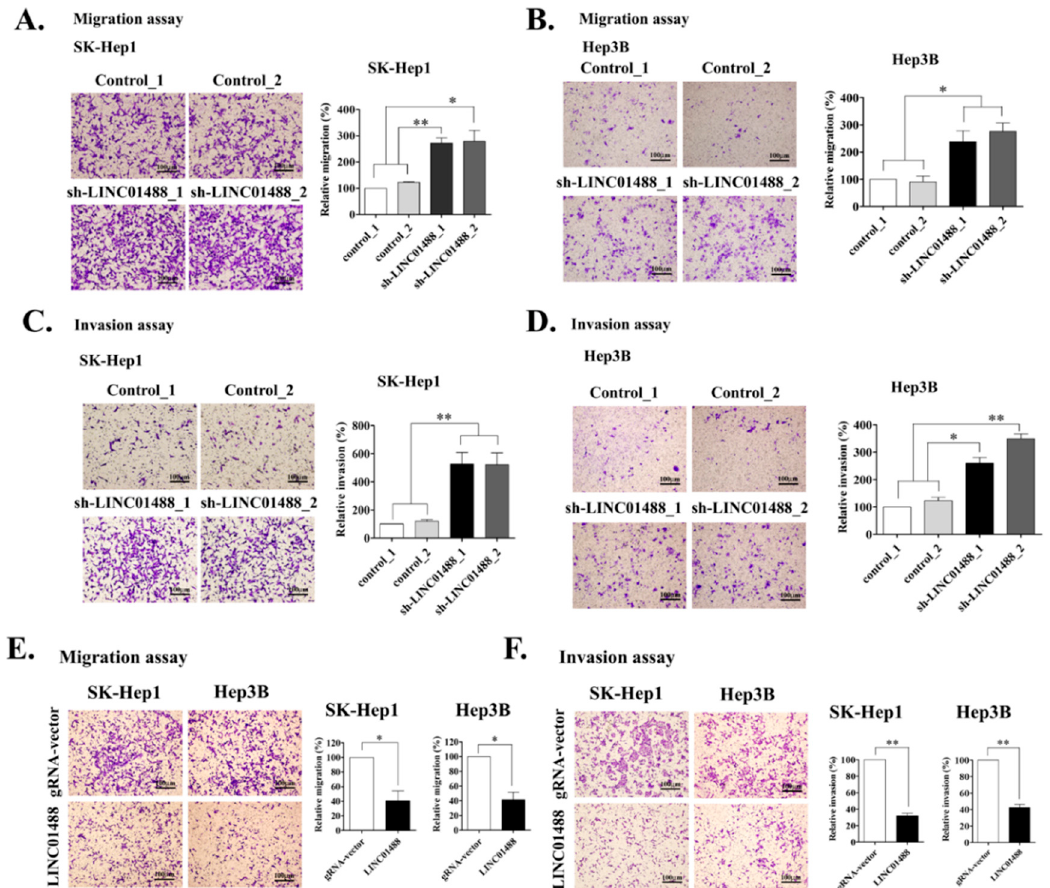
Figure 3. Upregulation of LINC01488 suppresses hepatoma cell migration and invasion ability in vitro. Migration assay on LINC01488 knockdown ( A ) SK-Hep1- and ( B ) Hep3B cells. Invasion assay on ( C ) SK-Hep1- and ( D ) Hep3B cells depleted of LINC01488. ( E ) Migratory and ( F ) invasive abilities of LINC01488-overexpressing SK-Hep1 or Hep3B cells in vitro. Quantified data are shown next to each graph. Data are presented as means ± SD (* p < 0.05; ** p < 0.01).